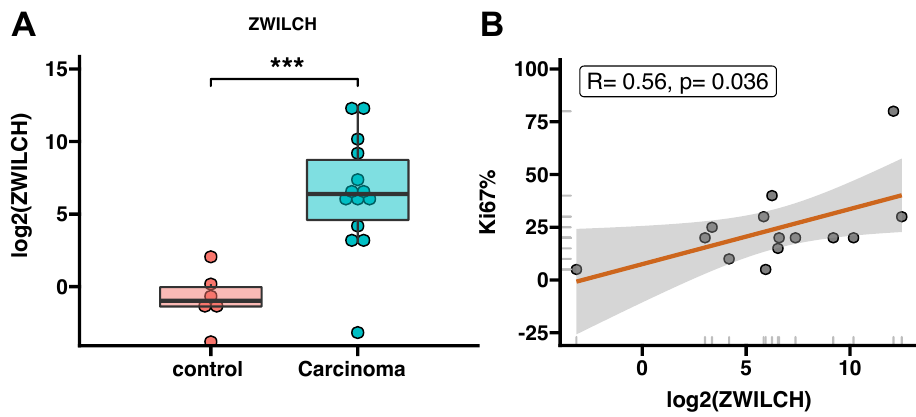
Figure 9. Adrenal expression of ZWILCH in patients with adrenocortical carcinoma ( n = 14). Compar- ison of ZWILCH gene expression in ACC samples compared to normal adrenals–controls ( n = 6). The bar plot presents the median with IQR range. Each dot represents ZWILCH expression in individ- ual patients. Statistical differences were determined by the Mann − Whitney U nonparametric test *** p < 0.001 ( A ). Correlation analysis of ZWILCH expression and KI67 ( B ) in adrenocortical carcinoma patients. The graph shows the logarithmic value of ZWILCH gene expression and the percentage of KI67 ( B ). Linear regression demonstrates a strong positive correlation between ZWILCH expression and the percentage of KI67 ( p = 0.036, R = 0.56) ( B